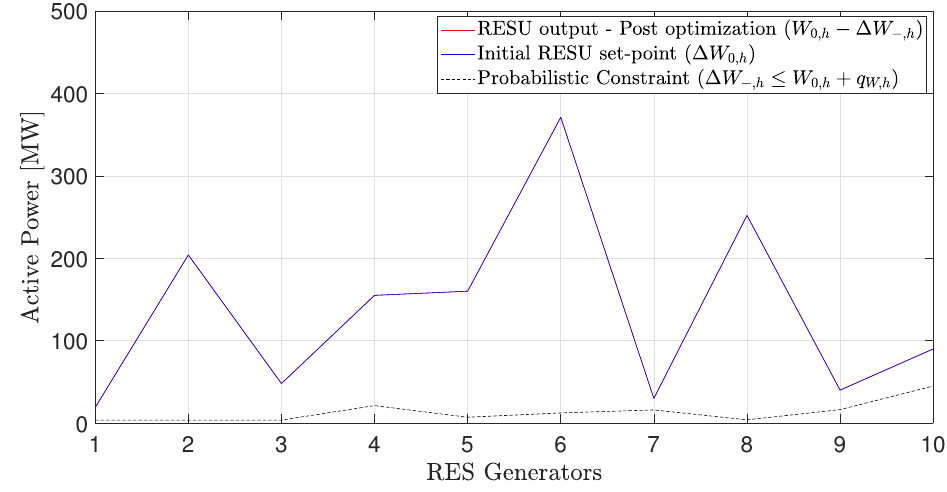
Figure 7. Active power set-points of RESUs after the active power control − Scenario